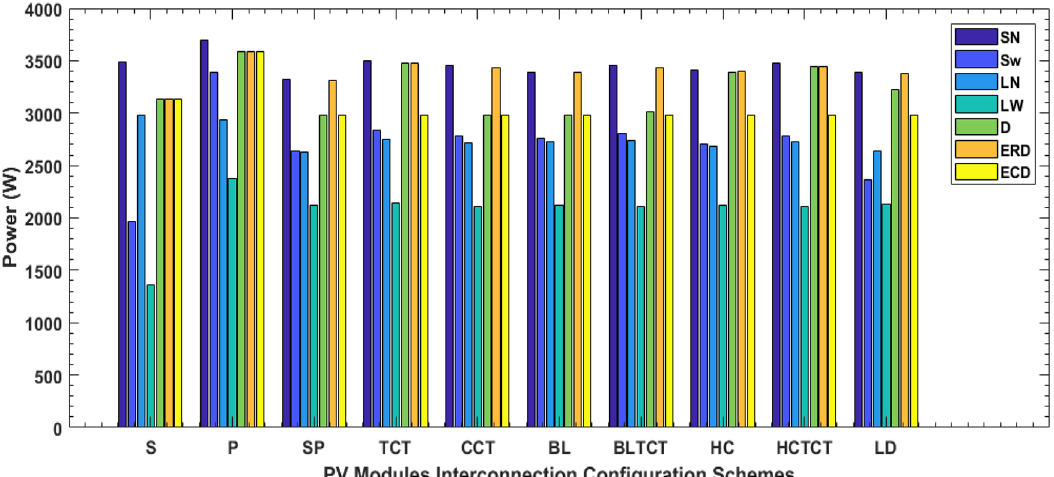
Fig. 11. Comparative illustration of maximum power generation of PV modules interconnection con fi guration schemes under partial shading patterns.